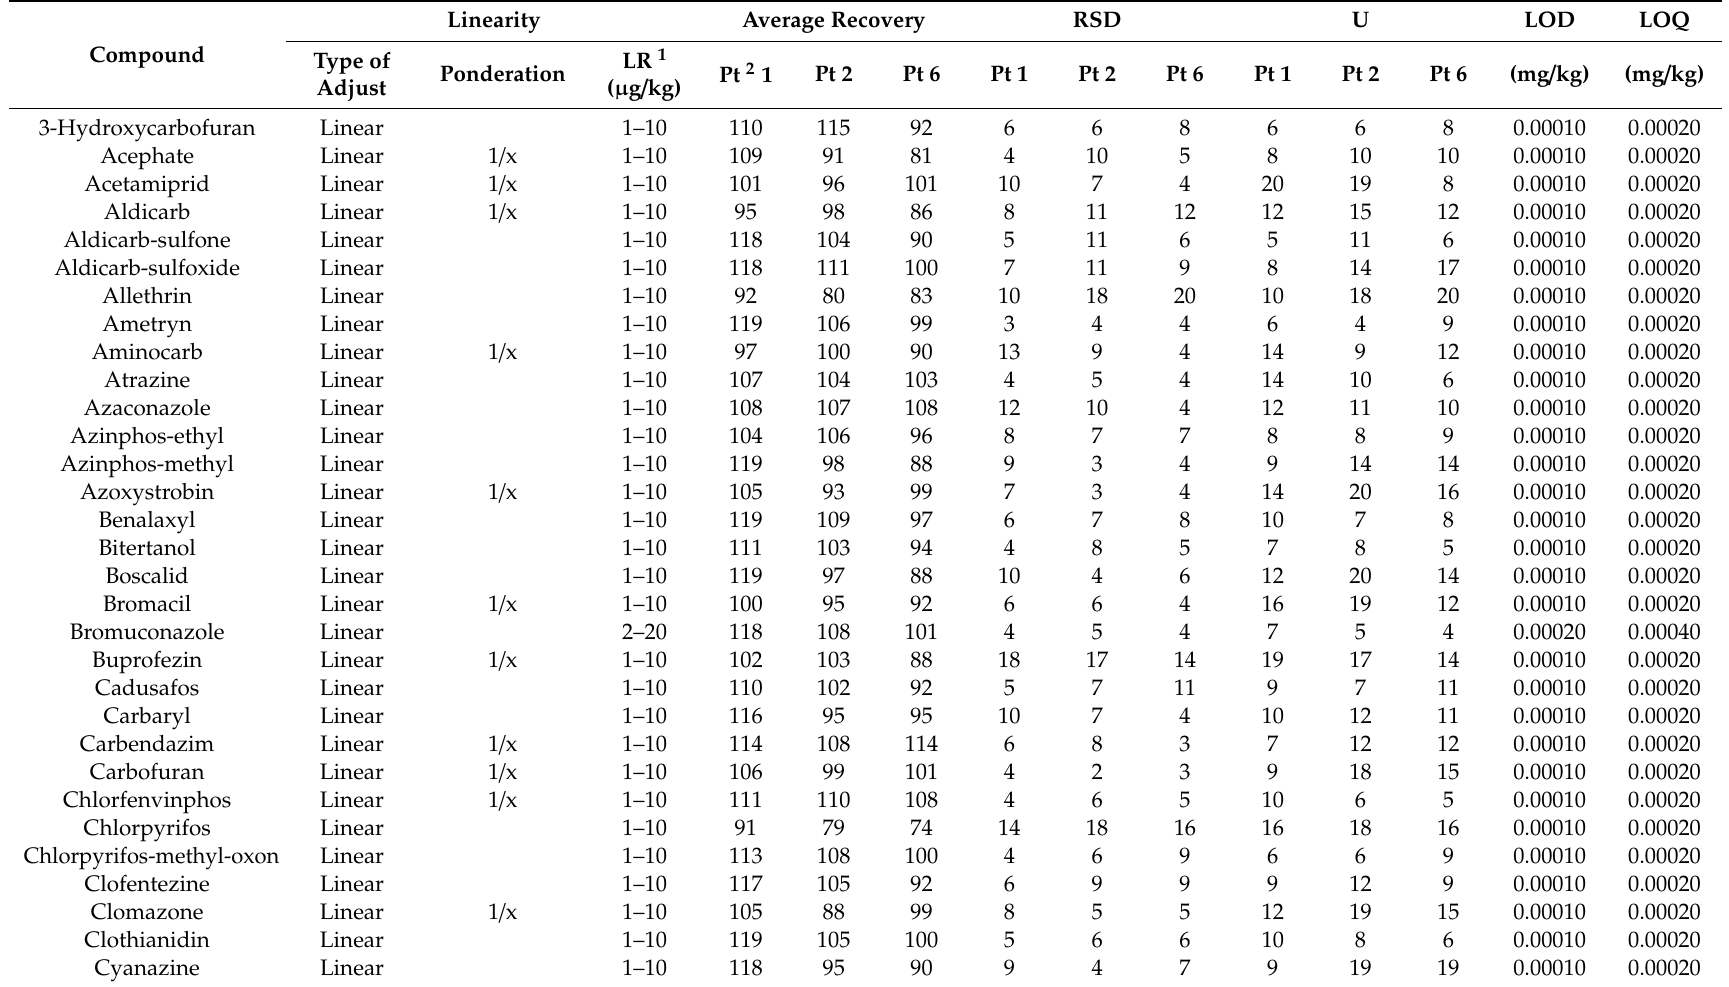
Table 3. Linearity, recovery (in %), repeatability relative standard deviation (RSD; in %), expanded measurement uncertainty (U; in %), limit of detection (LOD; in mg / kg), and limit of quantification (LOQ; in mg / kg) for each analyte of the LC-MS / MS method for analysis of pesticides in